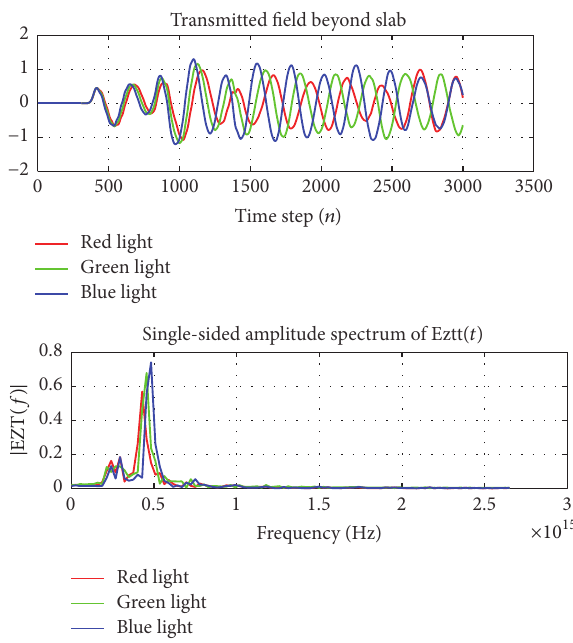
Figure 16: Transmitted field beyond the cloaking slab and equiva- lent amplitude spectrum versus frequency for red, green, and blue light corresponding to conditions in Table 5.